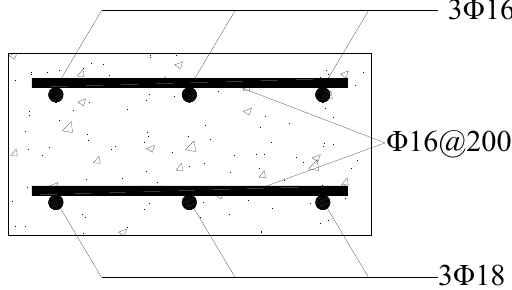
Figure 5. Details of reinforcement configuration.